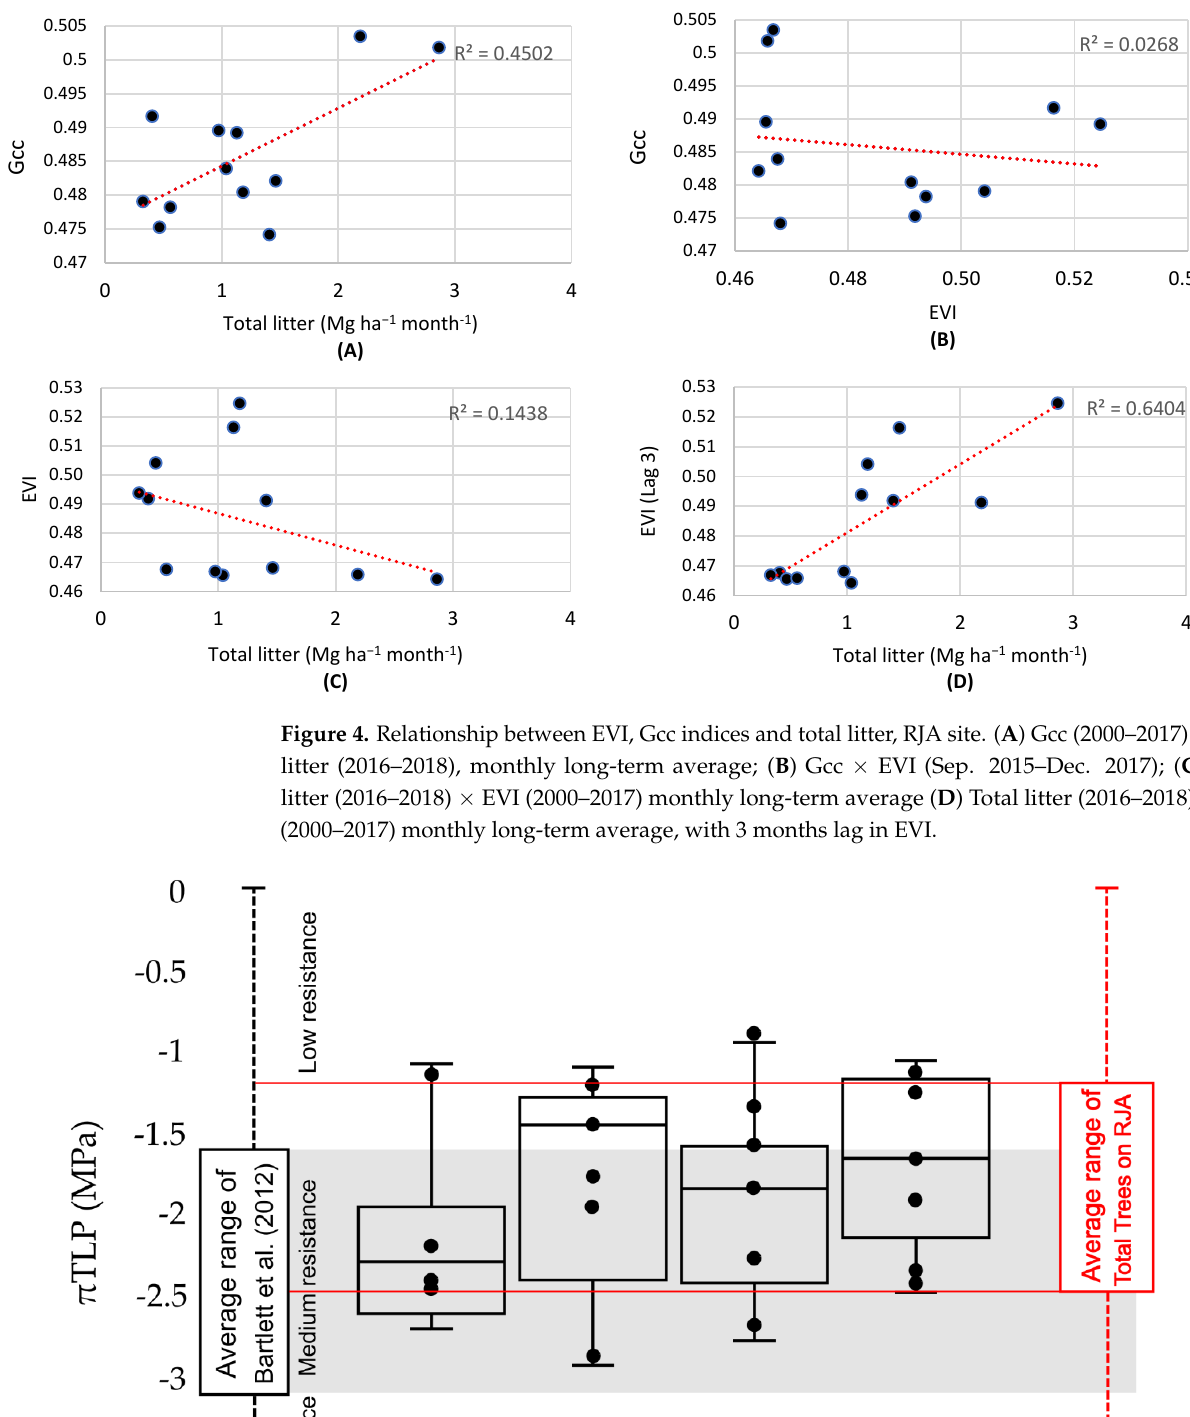
Figure 6. P 50 of species sampled in RJA and threshold based on [39]. Individuals included in the ≤ 20 cm diameter class (thin tree) had higher P 50 ( −1 .51 ± 1.03 MPa), which is equivalent to lower resistance to drought, and individuals with DBH > 20 cm (large tree) had lower values ( −3 .63 ± 1.21 MPa), which means higher drought resistance (Table 3).